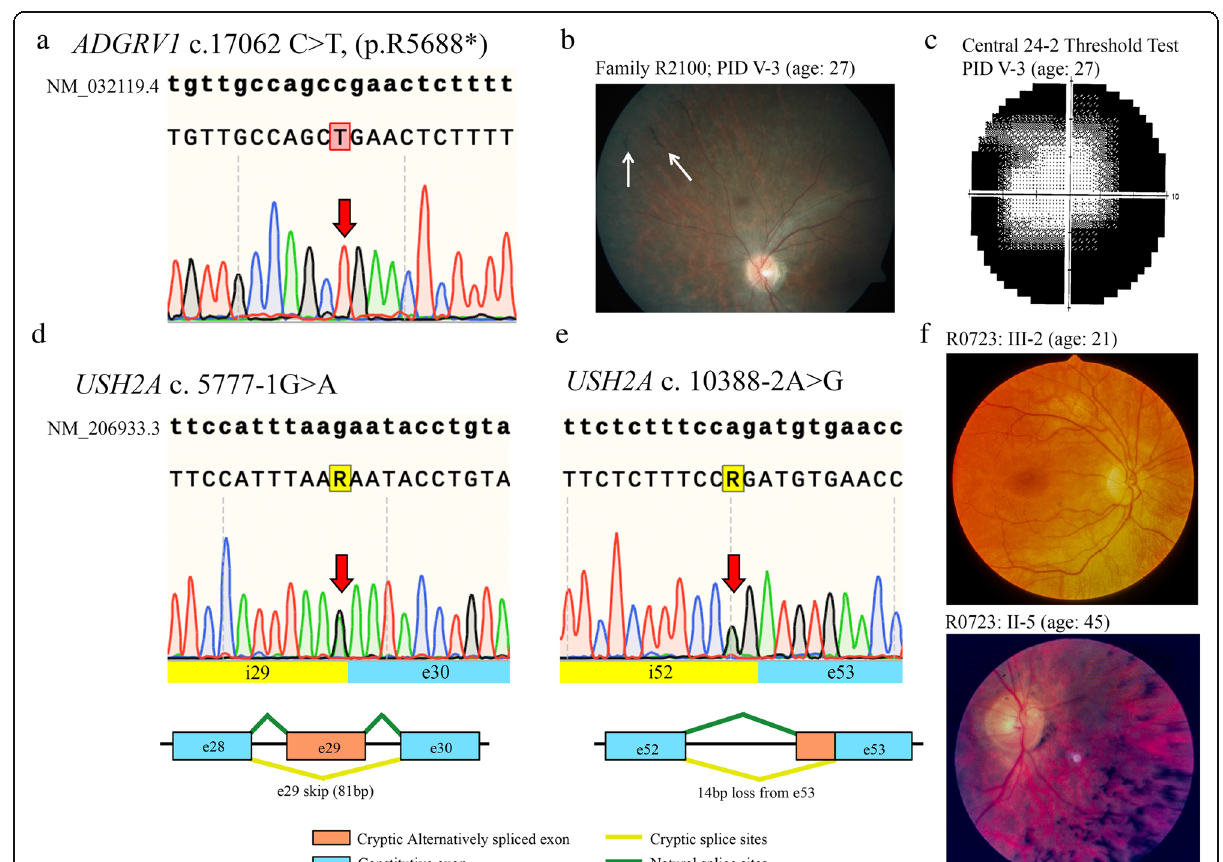
Fig. 2 Genomic and clinical findings of families in this study. a) Sequence electropherogram of ADGRV1 c. 17062C > T. Red arrow indicates this homozygous substitution, b) Retinal photograph of PID V-3 (Family R2100). White arrows highlight the presence of bone spicules, c) Central 24 – 2 visual threshold test of PID V-3 illustrating a deterioration of peripheral visual acuity, d) Sequence electropherogram of USH2A c. 5777-1G > A. This splicing pathogenic variant causes exon skipping and the in-frame deletion of 81 bp, e) Sequence electropherogram of USH2A c. 10,388-2A >